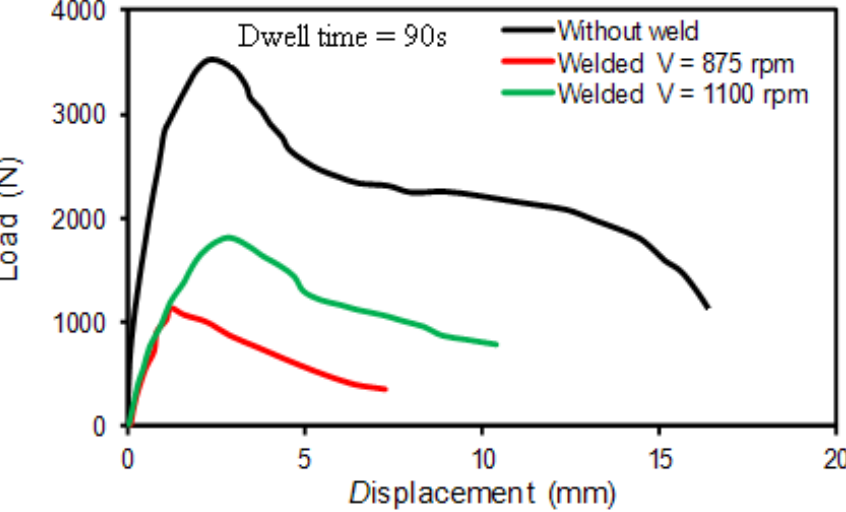
Figure 6: Load versus displacement curves of specimens for dwell time =90s